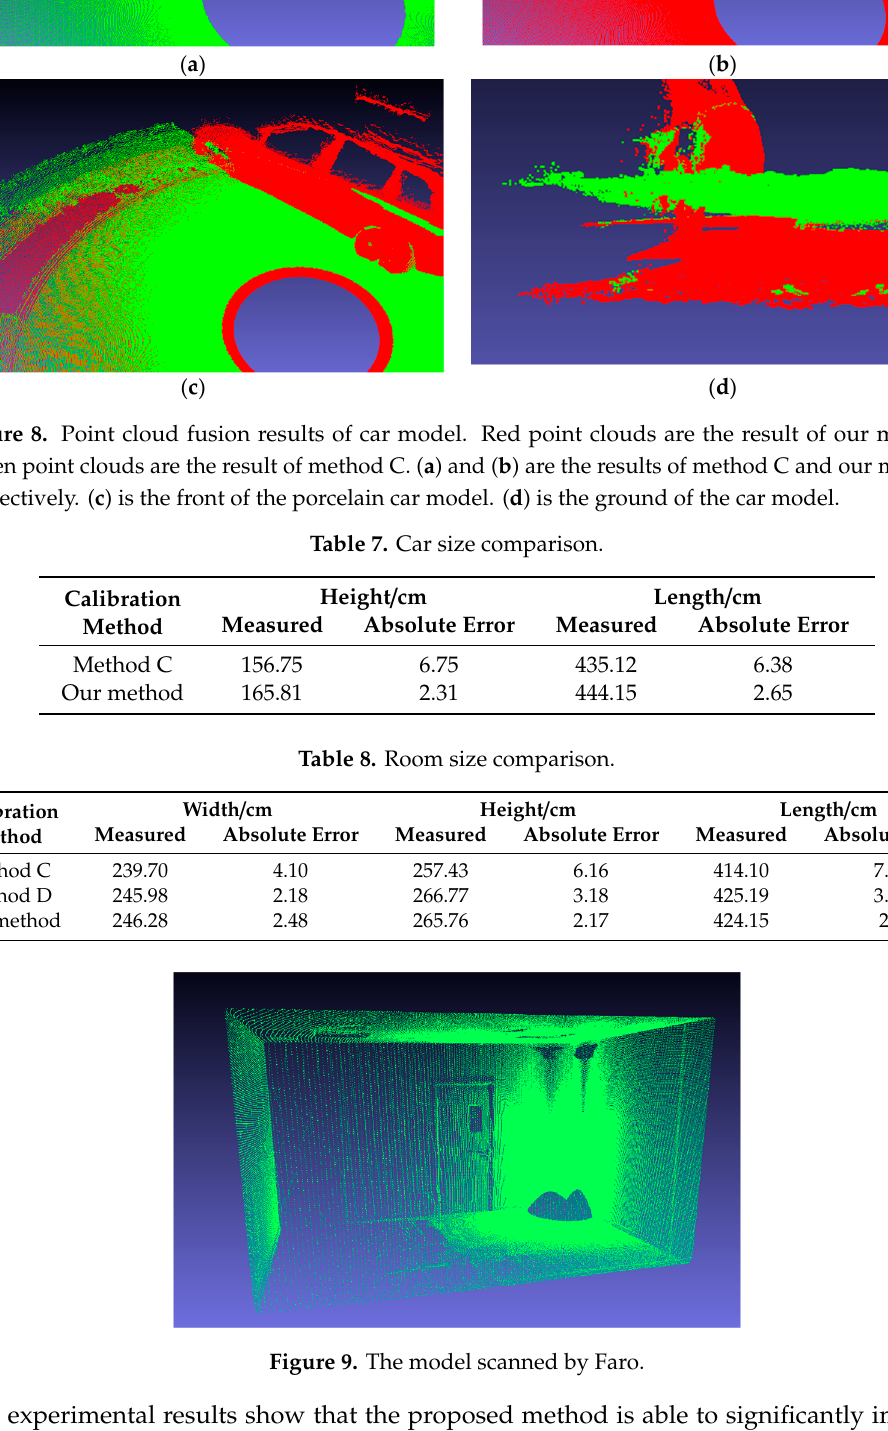
Figure 9. The model scanned by Faro .